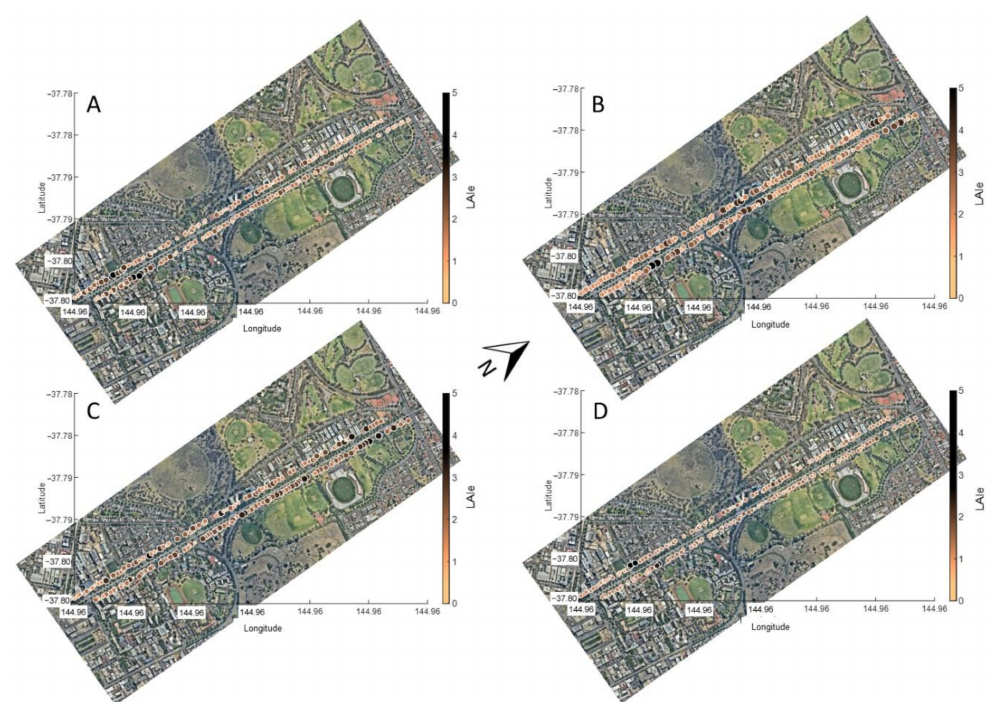
Figure 7. Mapping of effective leaf area index ( LAIe ) along the Royal Parade (5.04 Km) of 172 trees using the proposed urban tree monitoring system for four different dates: ( A ) 17 November 2016, ( B ) 29 November 2016, ( C ) 19 December 2016, and ( D ) 16 January 2017. Different colors and relative circle sizes correspond to the LAIe scale.